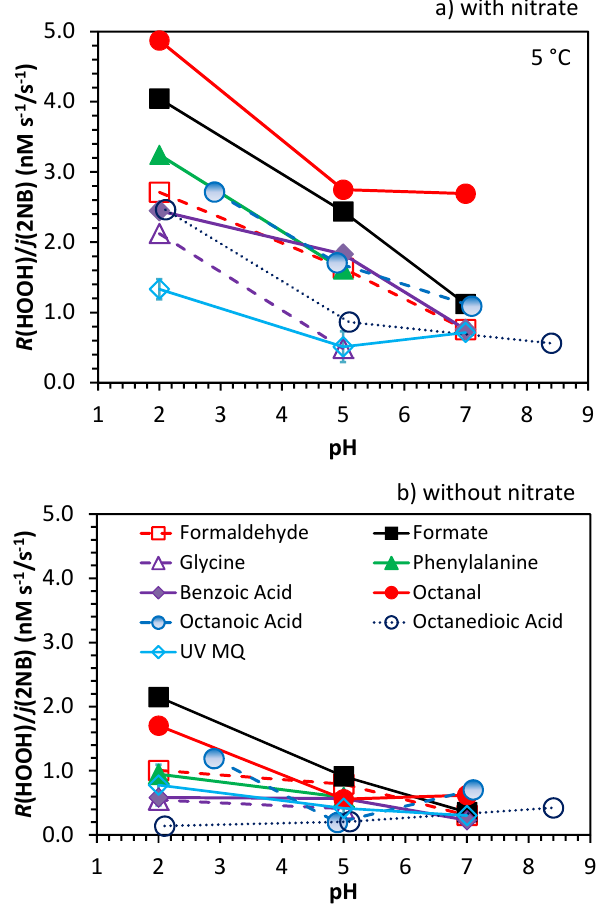
Fig. 4. pH dependence of hydrogen peroxide production (5 ◦ C, nor- malized by j (2NB)) for illuminated solutions containing: a) model compound (200µM) and nitrate (500µM), and b) model compound only. UV Milli-Q water did not contain a model compound. Error bars (blue) are the 95% confidence interval of UV Milli-Q water